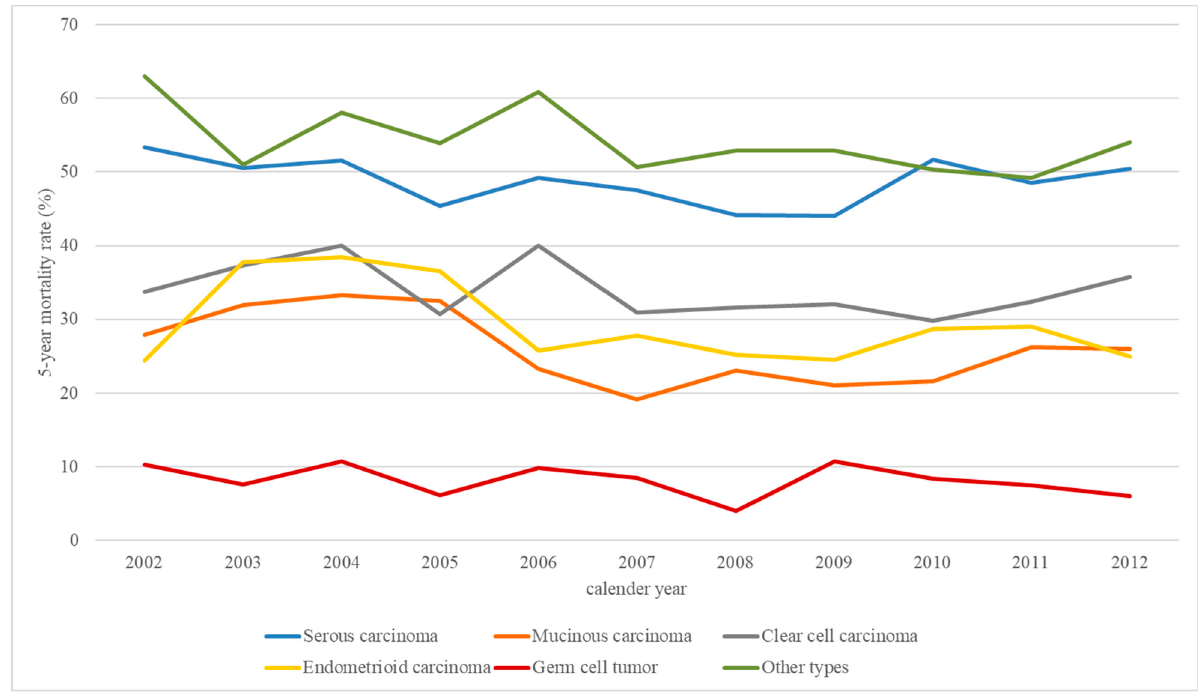
Figure 5. Trends of the 5-year mortality rate of patients with different types of ovarian cancer.